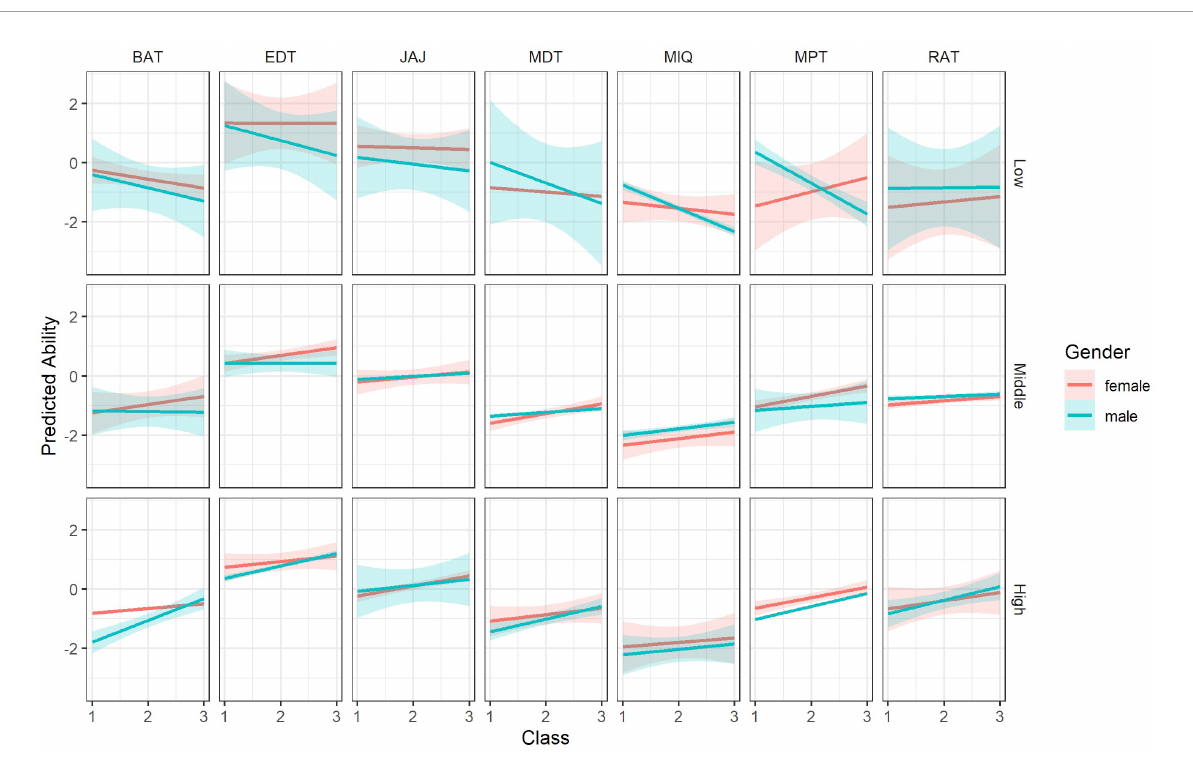
FIGURE2 Predicted ability values for the seven performance tests by class (X-axis) and gender (red = females, blue = males) for the three levels of General Music Sophistication. BAT, Beat Alignment Test; EDT, Emotion Discrimination Test; JAJ, Jack&Jill Working Memory Test; MDT, Melody Discrimination Test; MIQ, Matrix Reasoning; MPT, Mistuning Perception Test; RAT, Rhythm Ability